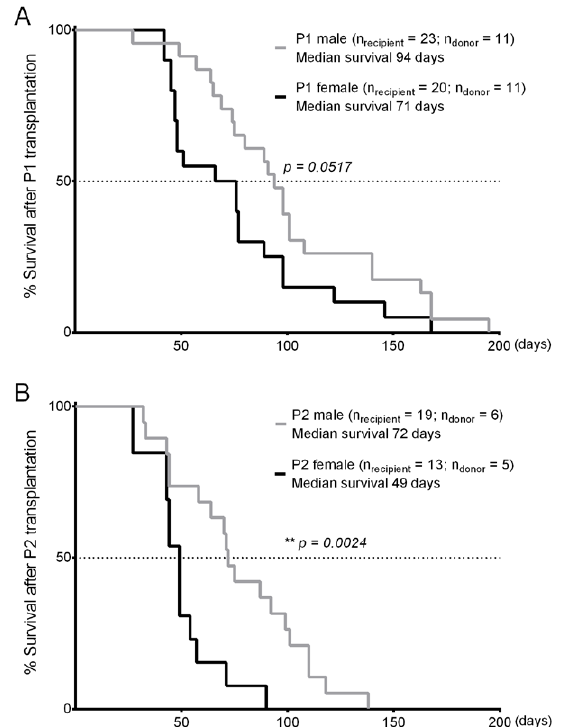
Figure 3. Significant sex difference in the survival of recipients after chronic lymphocytic leukemia (CLL) transplantation. ( A ) Kaplan–Meier curves of Passage 1 (P1) wild type (WT) recipient mice after syngeneic transplantation with murine CLL cells showing longer survival of males than females. Eleven male donor clones were transplanted in 23 male recipients; Eleven female clones were transplanted in 20 female recipients. Median survival: P1 males = 94 days, P1 females = 71 days; Mantel-Cox logrank test: p = 0.0517. ( B ) Kaplan–Meier curves of Passage 2 (P2) WT recipient mice after serial syngeneic transplantation with murine CLL cells showing longer survival of males than females. Six P1 male clones were transplanted in 19 male recipients; Five P1 female clones were transplanted in 13 female recipients. Median survival: P2 males = 72 days, P2 females = 49 days; Mantel–Cox logrank test: ** p = 0.0024.